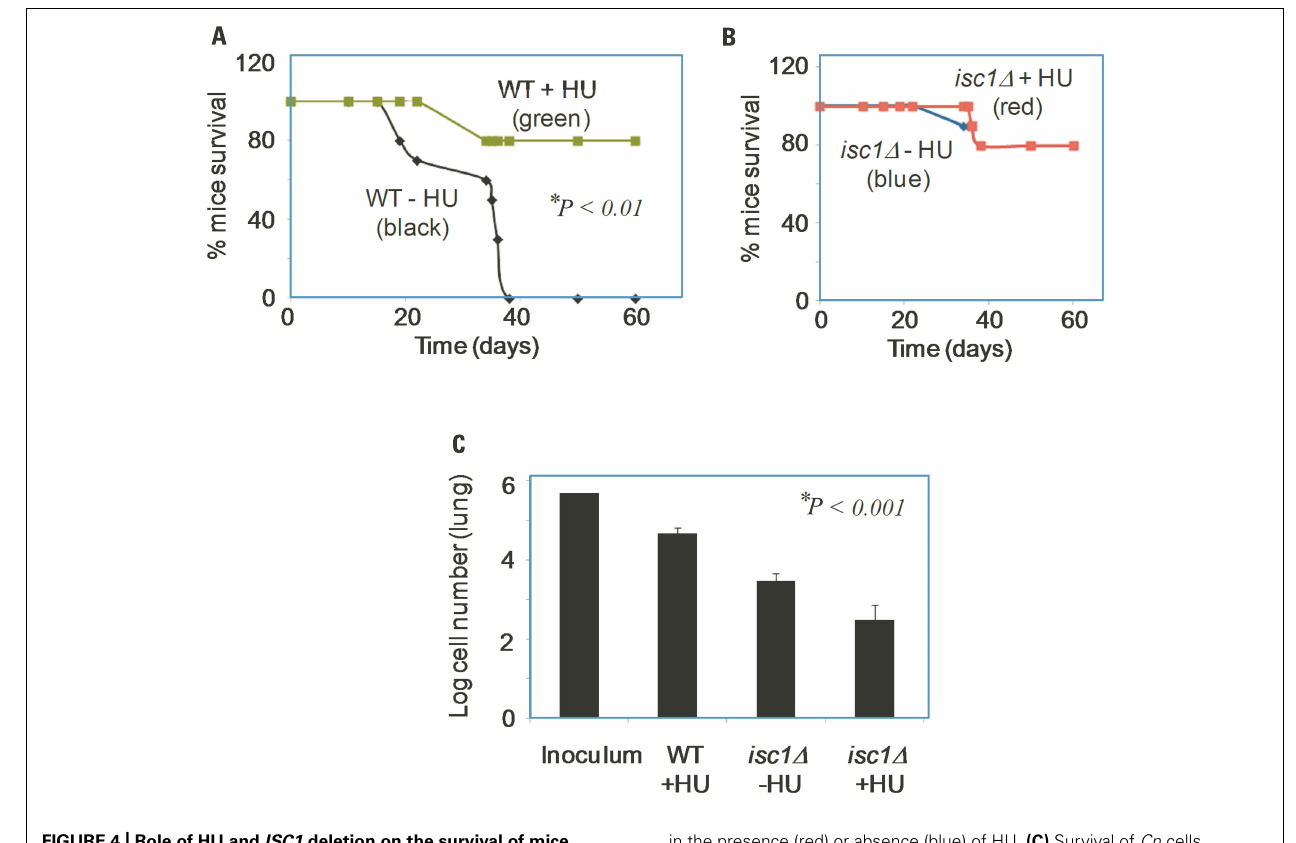
in the presence (red) or absence (blue) of HU. (C) Survival of Cn cells in lung tissue of CBA/J mice after 60 days of infection. Lung tissues were collected from mice and Cn CFU was counted by plating on YPD